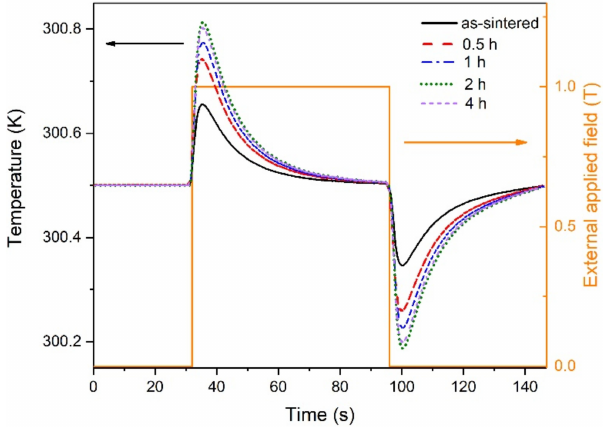
Figure 9. Variation of temperature due to the changing of in-plane magnetic field 10 kOe of the CoFe-coated samples and as-sintered sample at the setpoint 300.5